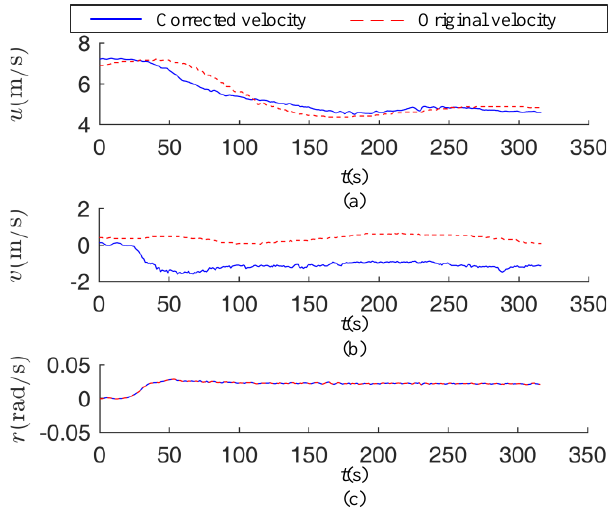
Figure 9. Correction of drift distance induced by the wind, waves and currents for +20° turning circle test.